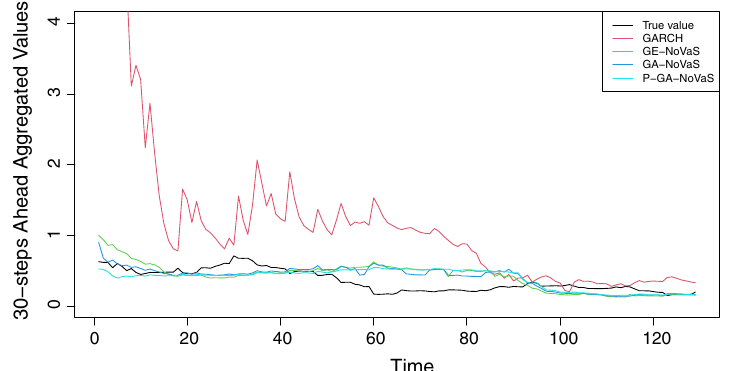
Fig. 7 The curves of different methods’ 30-steps ahead aggregated predictions on volatile CADJPY data and actual